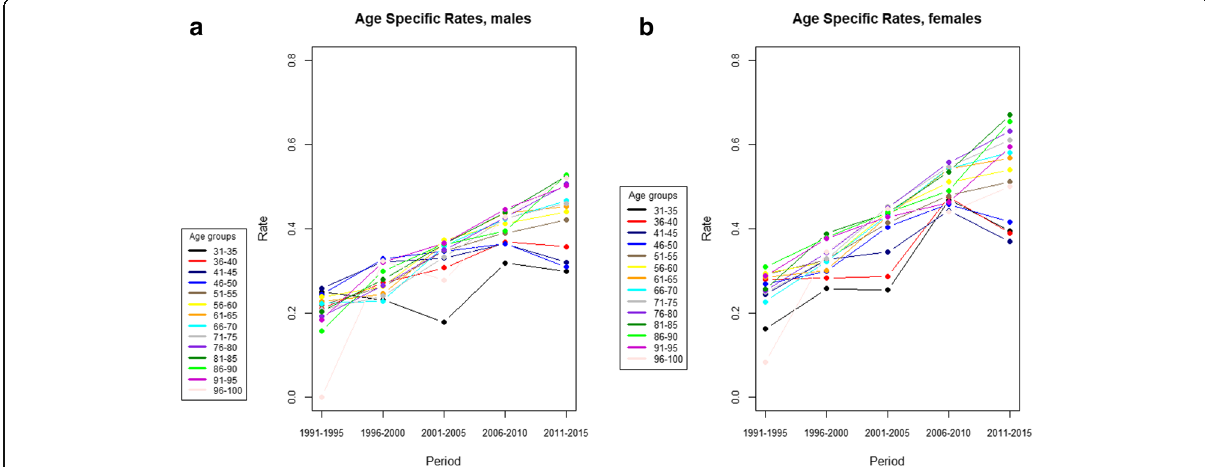
Fig. 2 Observed pain rate in males and females in the ATHLOS dataset. a : age-specific pain rates by age for males. b : age-specific pain rates by age for